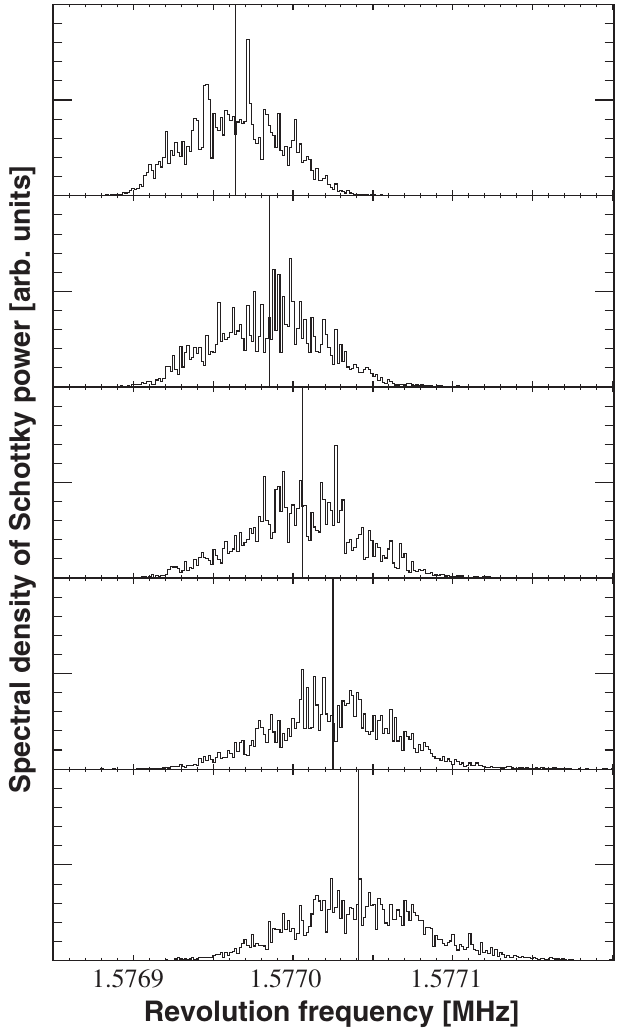
FIG. 4. Schottky power spectra obtained during one ten- minute cycle and scaled to harmonic number 1. Although the data were recorded every minute, for ease of presentation, only the results from the even minutes are shown, starting from top to bottom. Each spectrum is a true representation of the momentum distribution, and the shift over the cycle is a measure for the energy loss. The mean frequencies resulting from the fits are indicated by the vertical lines. Since these data were taken above the transition energy, (cid:6) is negative and the frequency increases through the